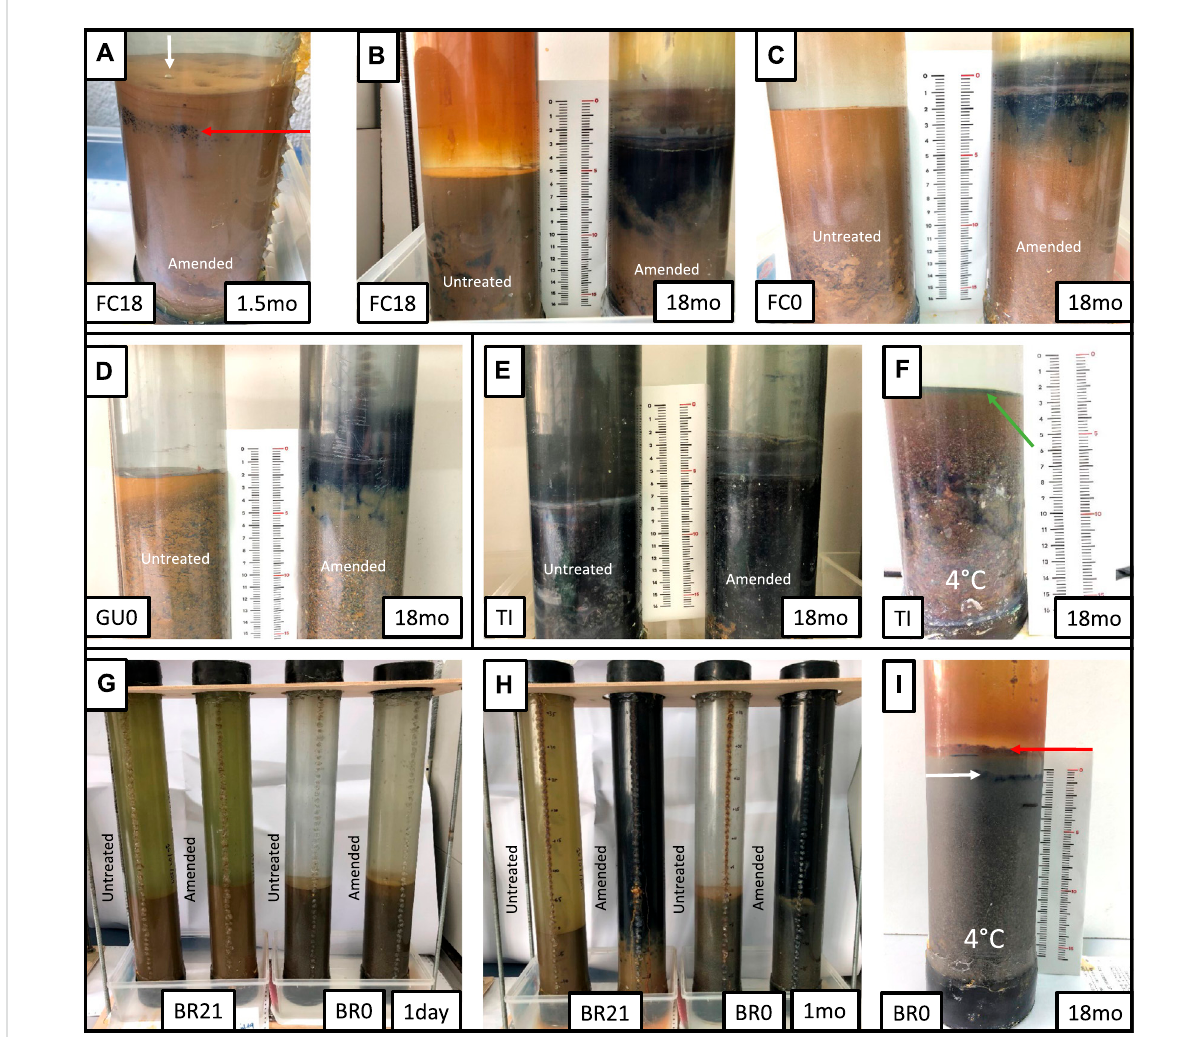
FIGURE 1 Visual evolution in selected incubation columns at different incubation periods (right bottom corner in months). (A) The onset of black layer development (red arrow) and gas bubbles (white arrow) in the sediment of glycerol-amended IC from Filón Centro 18 m (monimolimnion) (B) the fi nal state (18 months) of glycerol-amended (right) and untreated (left) ICs from Filón Centro 18 m (monimolimnion) (C) Filón Centro 0 m (mixolimnion) and (D) Guadiana 0 m (mixolimnion). (E) Tintillo acidic stream evolved sediment (18 months) (F) cool-stored Tintillo IC remained green (green arrow) after 18 months of incubation. (G,H) A single month evolution observed in Brunita 21 m (monimolimnion) and Brunita 0 m (mixolimnion) amended ICs, contrasting with unamended ICs all stored at room temperature. (I) Limited changes of cool-stored Brunita 0 m (mixolimnion) IC (18 months) developing a top red layer (red arrow) and very thin black layer (white